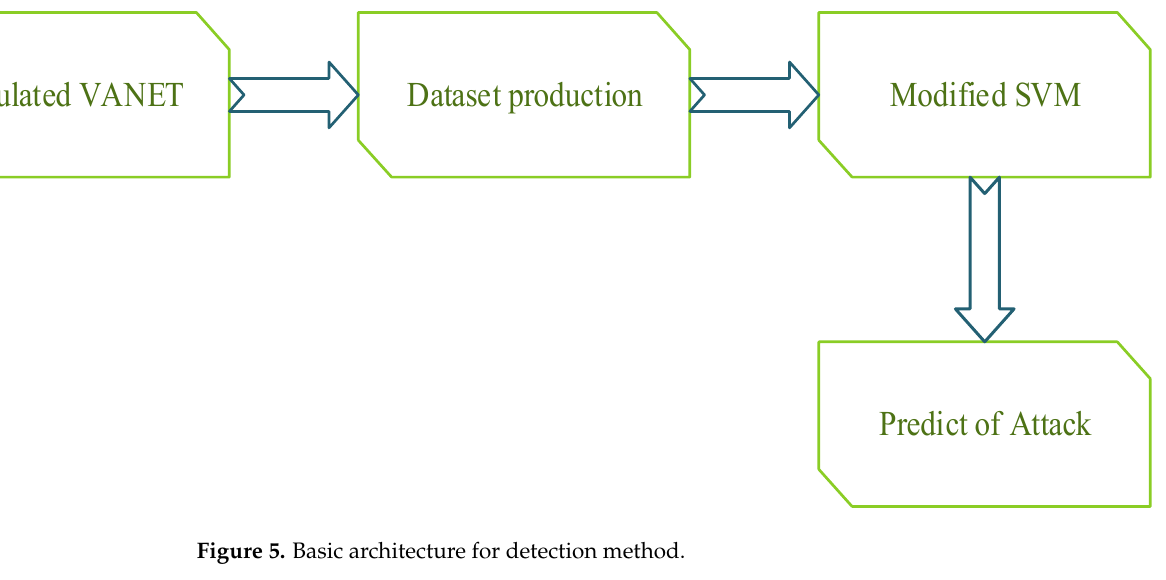
Figure 5. Basic architecture for detection method.